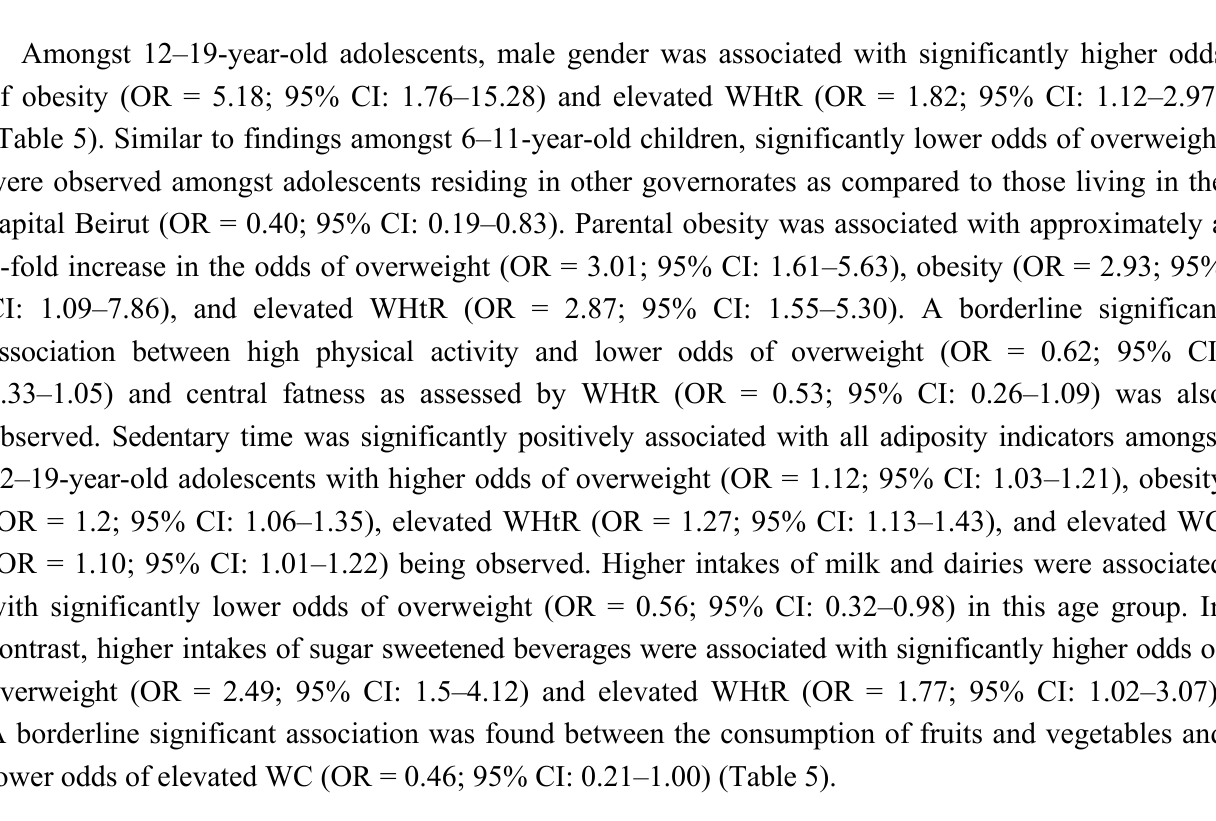
Table 5. Associations of socio-demographic, lifestyle and dietary factors with overweight, obesity, elevated WHtR and elevated WC in Lebanese 12–19-year-old